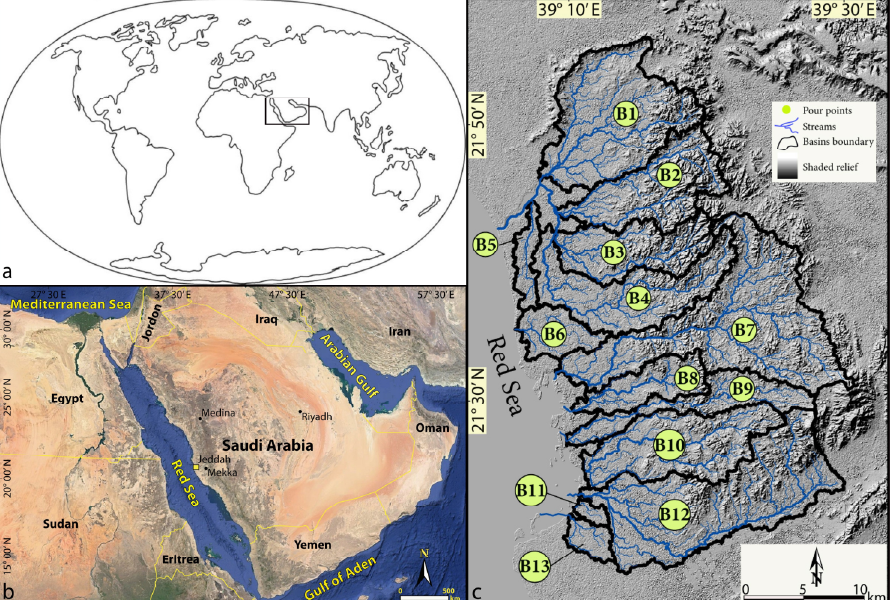
Figure 1. ( a ). Location of Saudi Arabia in world; ( b ). Location map showing the country of Saudi Arabia in relation to neighboring countries; ( c ). Shaded relief illustrating the examined basin, drainage streams, and pour points of the study basins (B1–B13).